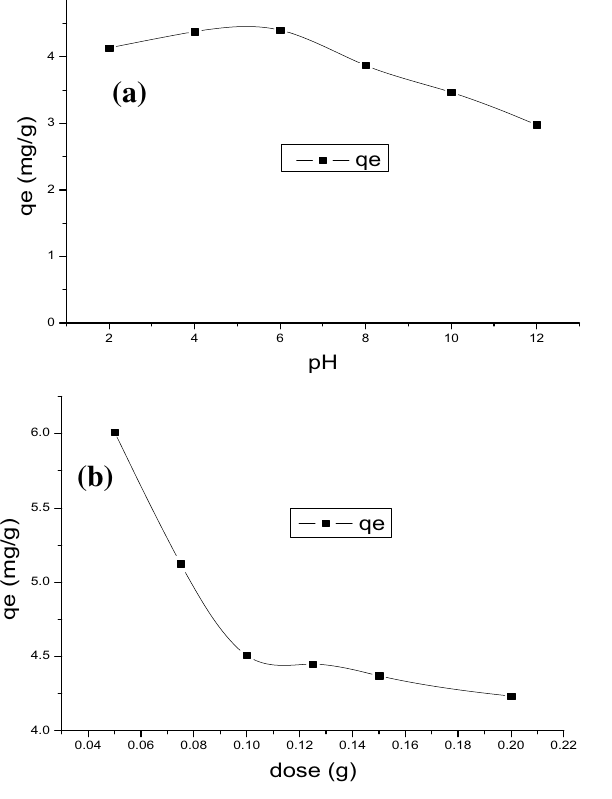
Fig. 2 a Effect of pH on the sorption of BPA onto nFe adsorbent dose on the sorption of BPA onto nFe 3 O 4